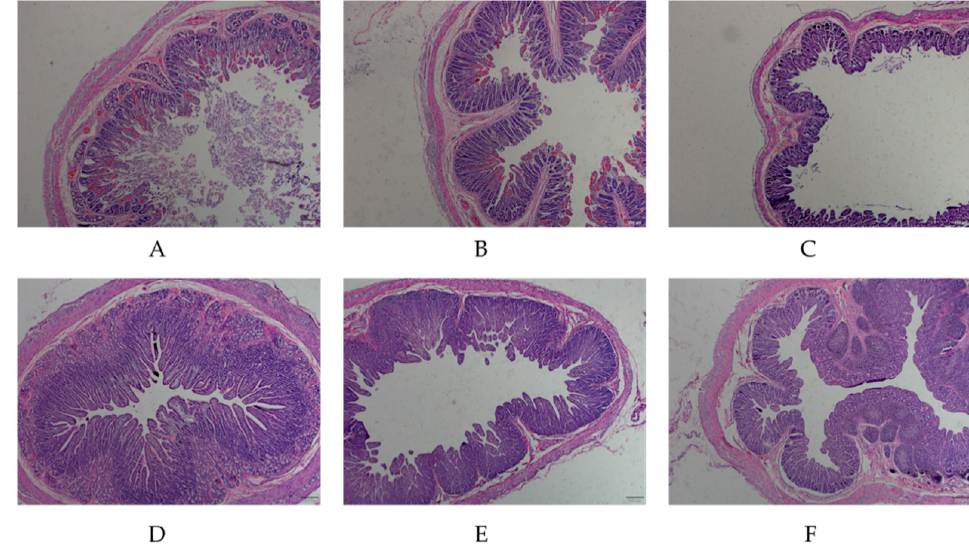
Figure 1. H&E-staining microscopic examination of the small intestine tissue from porcine epi- demic diarrhea virus (PEDV)-infected and normal piglets. ( A – C ) indicate the duodenum, jejunum, tissues of PEDV-infected piglets (40 × ); ( D – F ) indicate the duodenum, jejunum, ileum tissues of ileum tissues of PEDV-infected piglets (40×); ( D – F ) indicate the duodenum, jejunum, ileum tissues of normal piglets (40×). normal piglets (40 ×